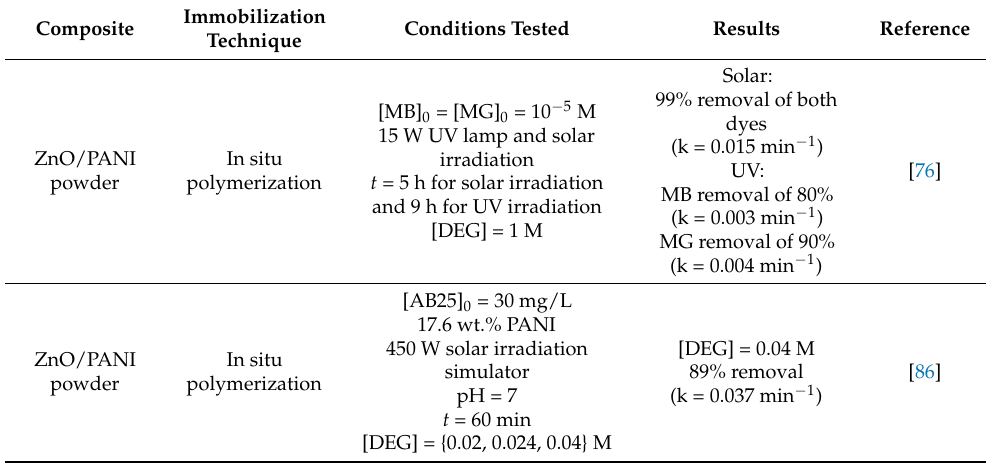
Table 10. Summary of studies that have analyzed the effect of adding DEG on the PANI-supported photocatalysis